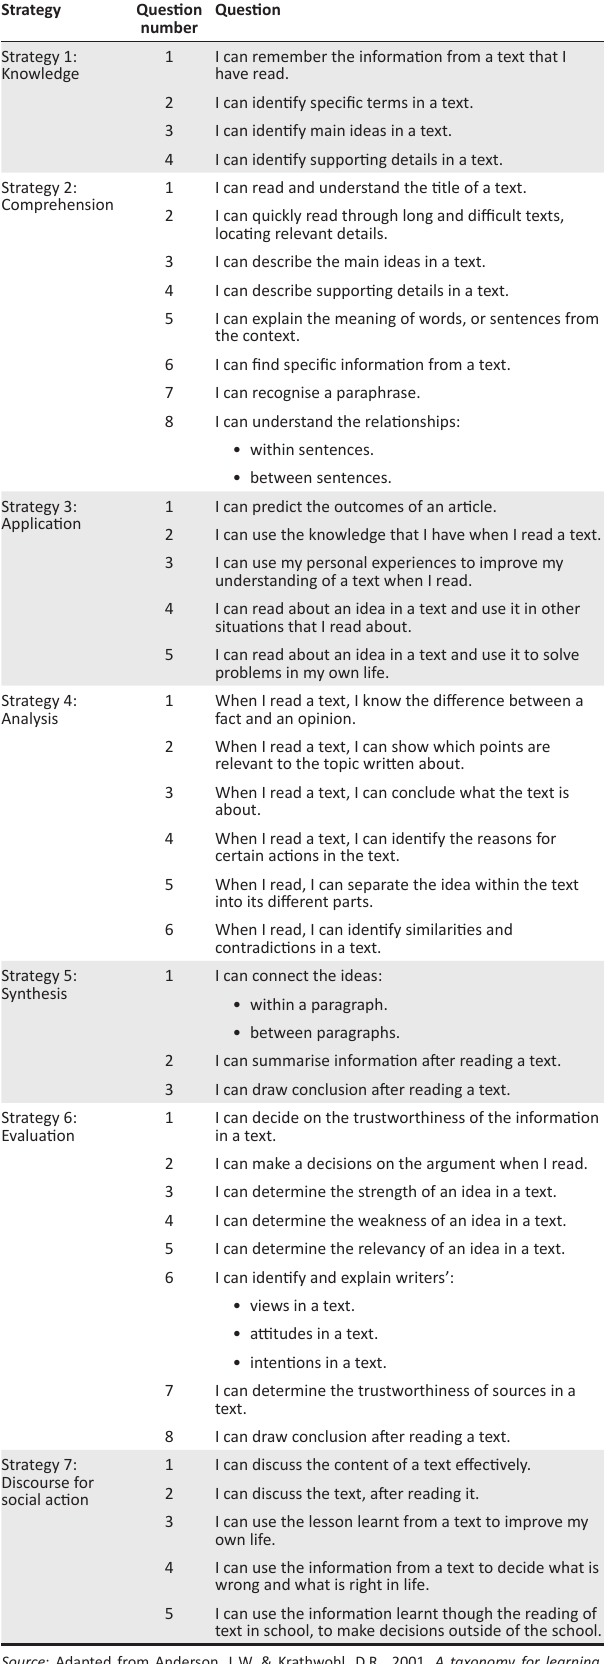
TABLE 1: Learners’ self-perceived and self-rated ability to use critical reading strategies. Strategy Question Question number Strategy 1: